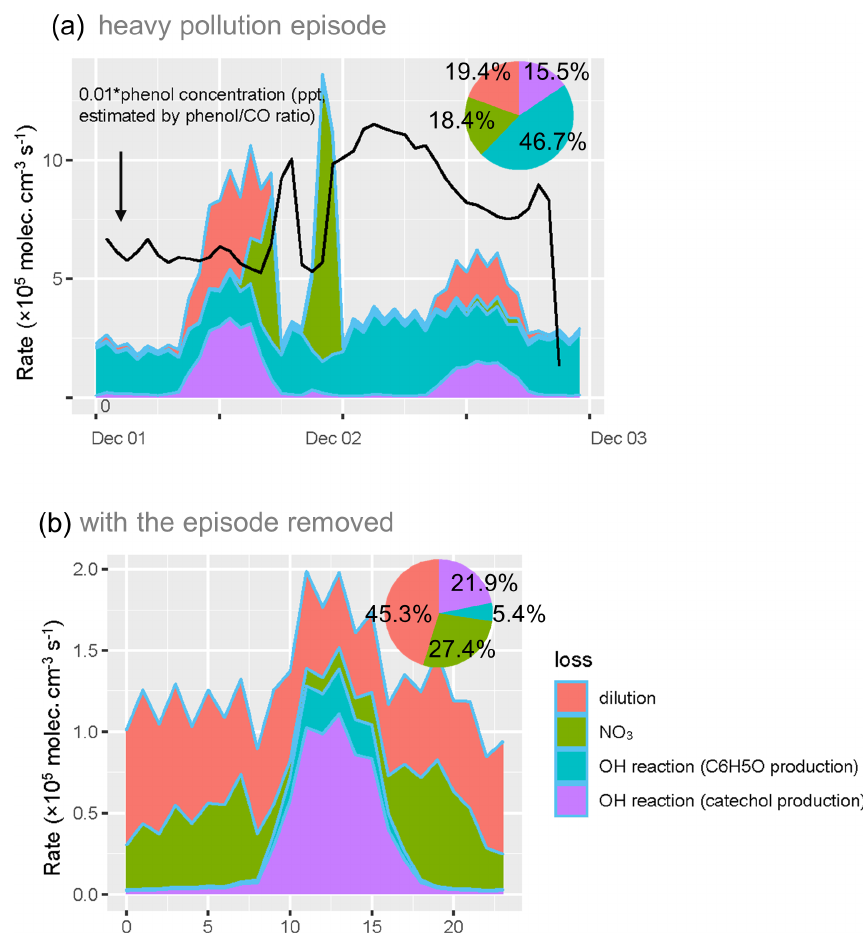
Figure 4. Time series and the loss rate of phenol during the heavy pollution episode (a) and diurnal profile of the loss of phenol with the heavy pollution removed (b)